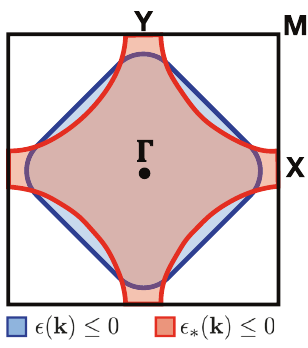
Fig. 1 Luttinger surface of the model self-energy. In black, the Brillouin zone with the high symmetry points. The non-interacting Fermi area, ϵ ( k ) ≤ 0, is drawn in blue, while the interacting Luttinger one, ϵ *( k ) ≤ 0, is in red. They are obtained, respectively, assuming ϵ ð k Þ ¼ (cid:2) 2 cos k x (cid:2) 2 cos k y (cid:2) μ , with μ = − 0.2, and ϵ (cid:4) ð k Þ ¼ (cid:2) 2 cos k (cid:2) 2 cos k þ 4 t 0 cos k k (cid:2) μ (cid:4) , with x y x cos y t 0 ¼ 0 : 3 and μ * such that both areas are equal, thus forcing by hand the same number of electrons in the non-interacting and interacting